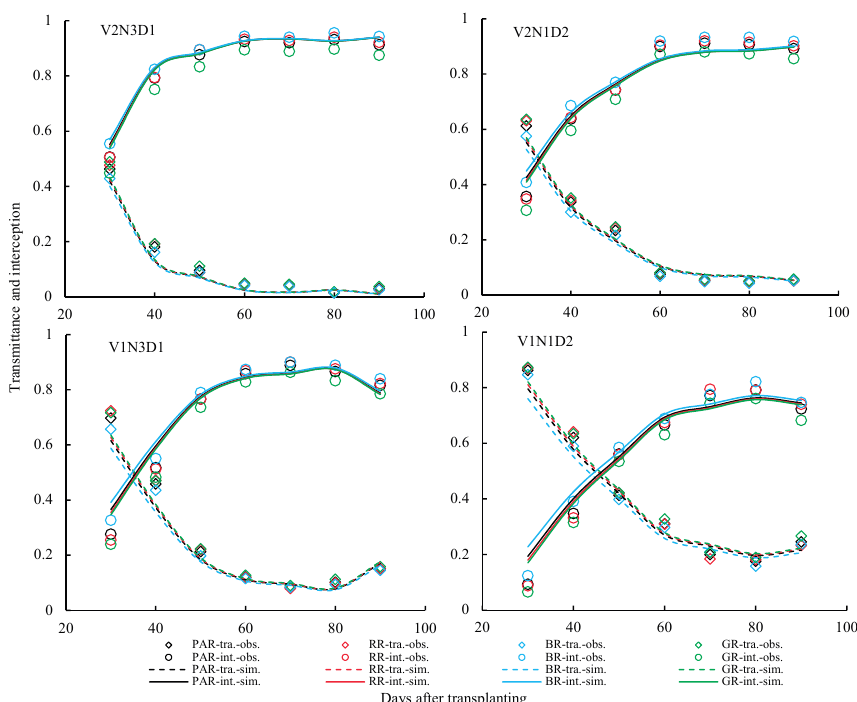
Figure 10. Comparison of simulated and observed radiation transmittance at different growth stages and under different nitrogen rates and planting densities for two rice varieties. V1, Wuxiangjing14; V2, Shanyou63.